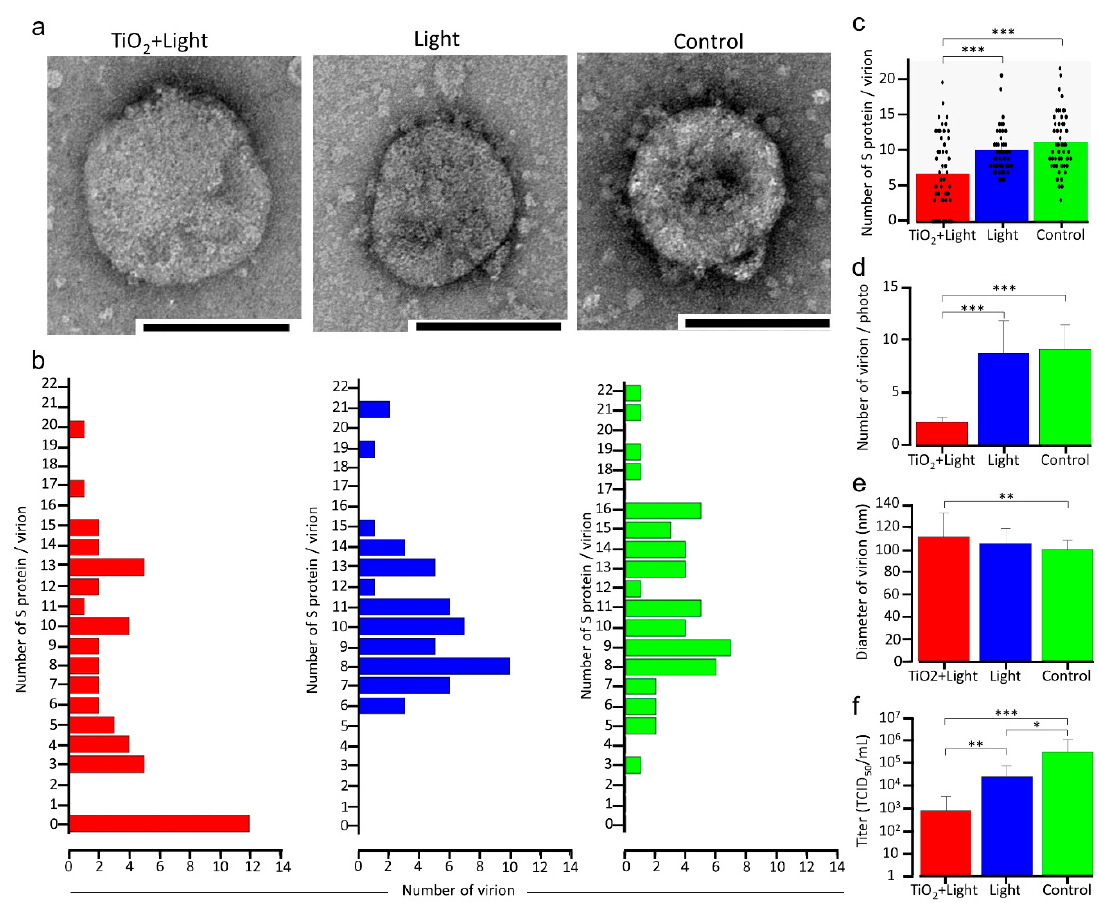
Figure 2. Changes in SARS-CoV-2 virion morphology due to LED-TiO 2 photocatalytic reaction. ( a ) SARS-CoV-2 (1 mL) titer of 1.78 × 10 6 TCID 50 /mL was placed on TiO 2 -coated sheet and subjected to photocatalytic reaction for 120 min before TEM imaging. Representative virion images in the TiO 2 + Light, Light, and control groups are shown. Bar = 100 nm. ( b ) Number of S proteins on single virions in individual TEM images of the TiO 2 + Light, Light, and control groups was counted, and distribution and mean number of S protein/virion are shown. n = 50/group. ( c ) Each dot represents a value of S protein of each virion in ( b ). ( d ) Virion number in an area of 170 μ m 2 in an individual TEM image is shown, n = 10. ( e ) Diameter of single virion in an individual TEM image is shown. n = 40. ( f ) Viral titer in each group was confirmed by TCID 50 assay. Each column and error bar represents the mean ± SD of results. All values were analyzed by two-way ANOVA followed by Tukey’s test. Asterisk indicates a statistically significant difference (* p < 0.05; ** p < 0.01; *** p < 0.001).